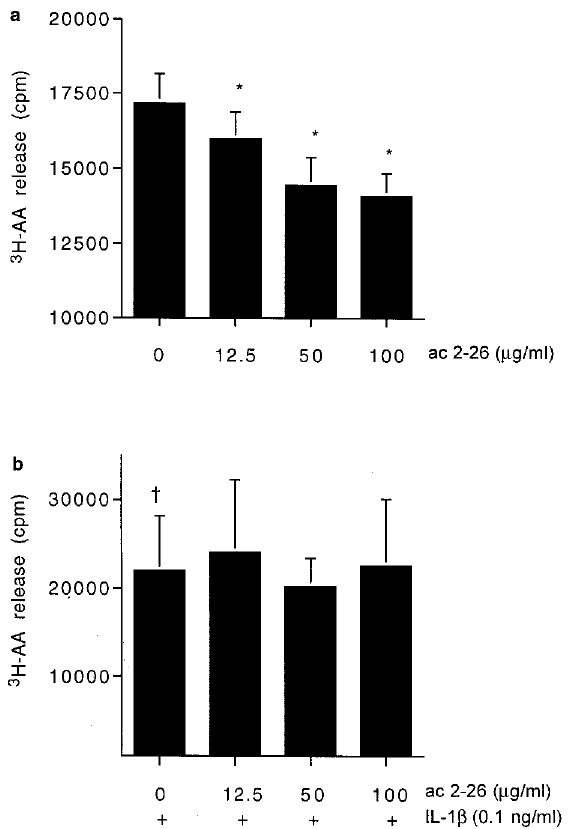
FIG. 2. Effect of annexin I peptide on human FLS PLA 2 activity. FLS were treated with (a) annexin I ac 2–26 (0–100 m g/ml), and/or (b) IL-1 b (0.1ng/ml) plus annexin I peptide for 8h. PLA 2 activity is expressed as 3 H-AA released. Values are the mean ±SEM of 8 experiments. * p < 0.05 versus untreated FLS, p < 0.01 versus untreated FLS.